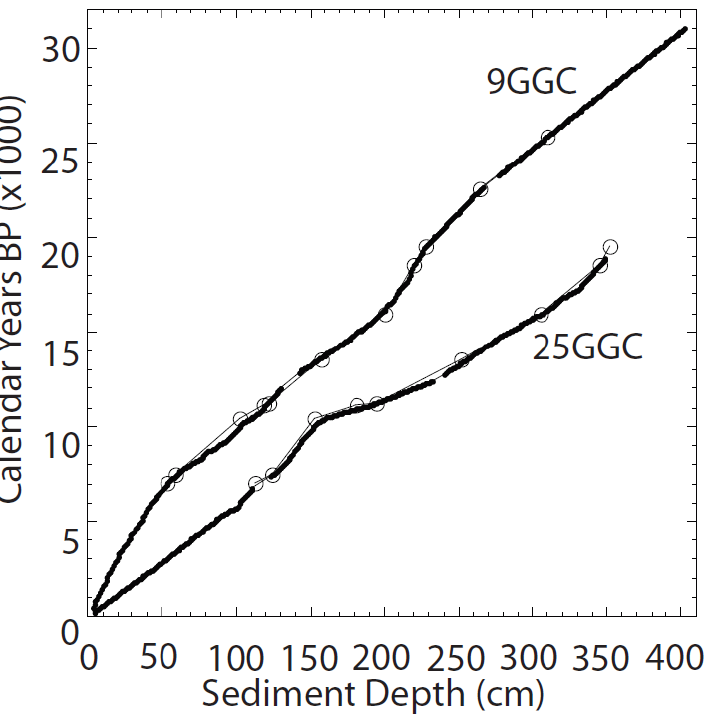
Figure 4. Time–depth plots for cores 9GGC and 25GGC. The open circles are calibrated radiocarbon dates used by Lund et al. (2017) [11] with linear interpolation to dates the cores. We built a revised chronology, as summarized in Supplementary Table S1, to create the more detailed chronologies shown here (dark lines). The revised chronostratigraphies were used to estimate sedimentation rate variability in both cores. The results are shown in Figure 5. There is a notable overall pulse of high sedimentation around the Pleistocene–Holocene transition (~10–16 ka). Superposed on this are multi-millennial variations in sedimentation rates that we can tie to our rock magnetic variability described below. In particular, note that colder intervals of the Late Pleistocene (Younger Dryas (YD) and Heinrich events H1 and H2) have lower sedimentation rates than the neighboring warmer intervals (Bolling–Allerod (B/A) and Dansgard–Oeschger (D/O) interstadial events 2–4).